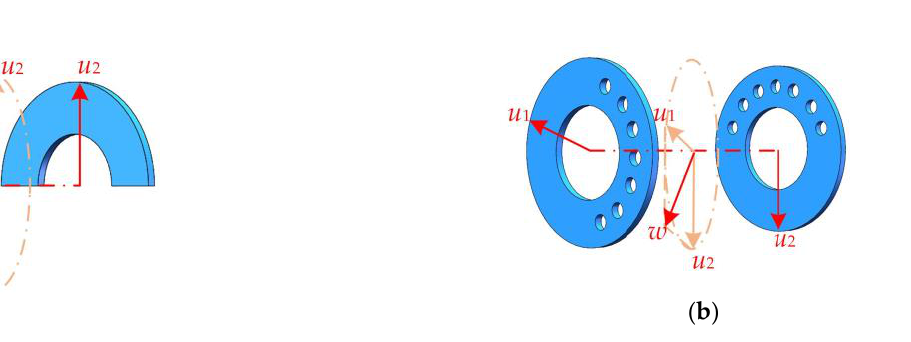
Figure 11. Schematic diagram of eccentric mass. ( a ) Adding weight; ( b ) reducing weight.